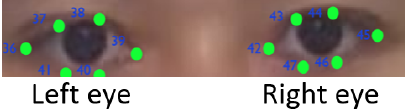
Figure 3. An example of eye-landmarks detected using the Python Dlib